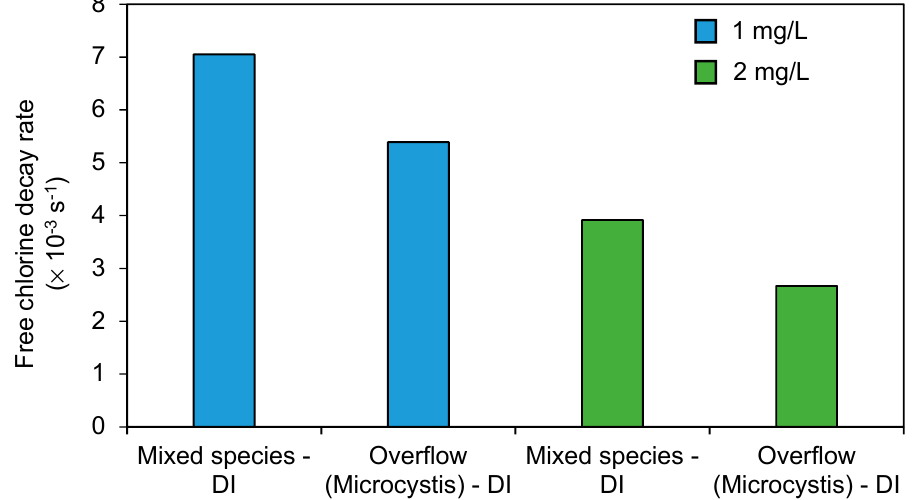
Figure 4. Impact of separation on the chlorine decay rate for the mixed species (feed water with Microcystis and Scenedesmus ) and the overflow ( > 93% Microcystis ) in DI water. Samples were collected from the mini-hydrocyclone after 30 min.